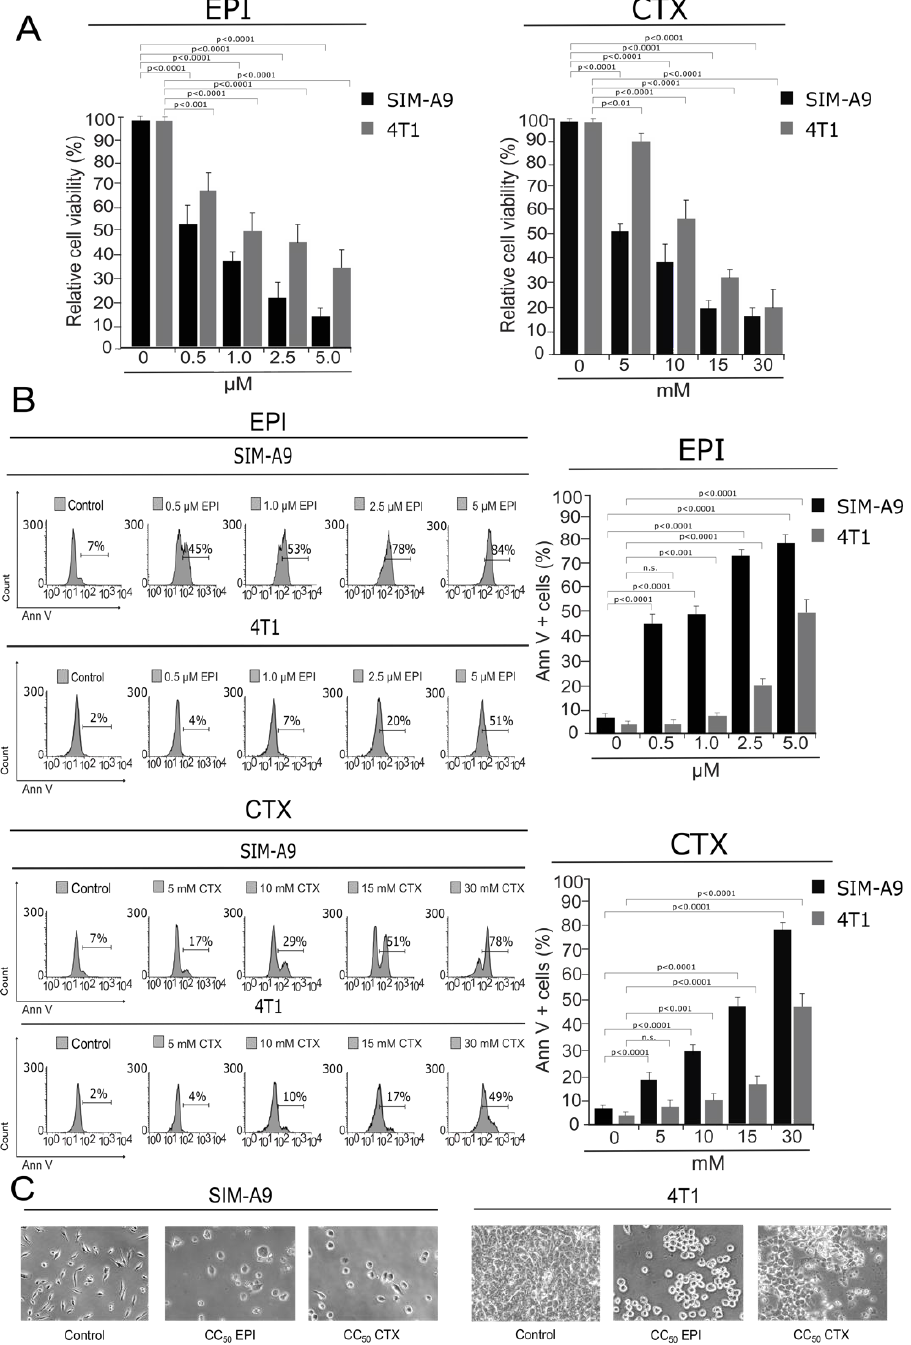
Figure 1: Cytotoxicity induced by EPI and CTX in SIM-A9 and 4T1 cells. SIM-A9 and 4T1 cells were treated with various concentrations (0.5, 1.0, 2.5 and 5.0 µM) of EPI, and 5, 10, 15 and 30 mM of CTX for 24 hours. A ) Cell viability was measured by resazurin assay represented as percentage of control (non-treated cell viability = 100 %) presenting means  SD. B ) Cell death was measured by flow cytom- etry through Annexin-V staining. The histograms refer to Annexin-V positive cells analyzed by FlowJo software (left) and the bar graphs represent the mean (  SD) (right). C ) Morphology assessment was performed with Nikon Eclipse TS100 using 20x